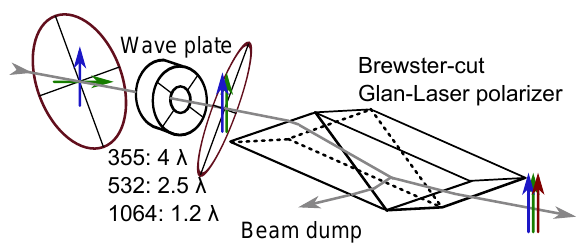
Figure 9. Wave plate and polarizer setup used to generate highly linear-polarized light at three wavelengths. The different polariza- tion states after SHG and THG are matched by the wave plate and afterwards purified by the